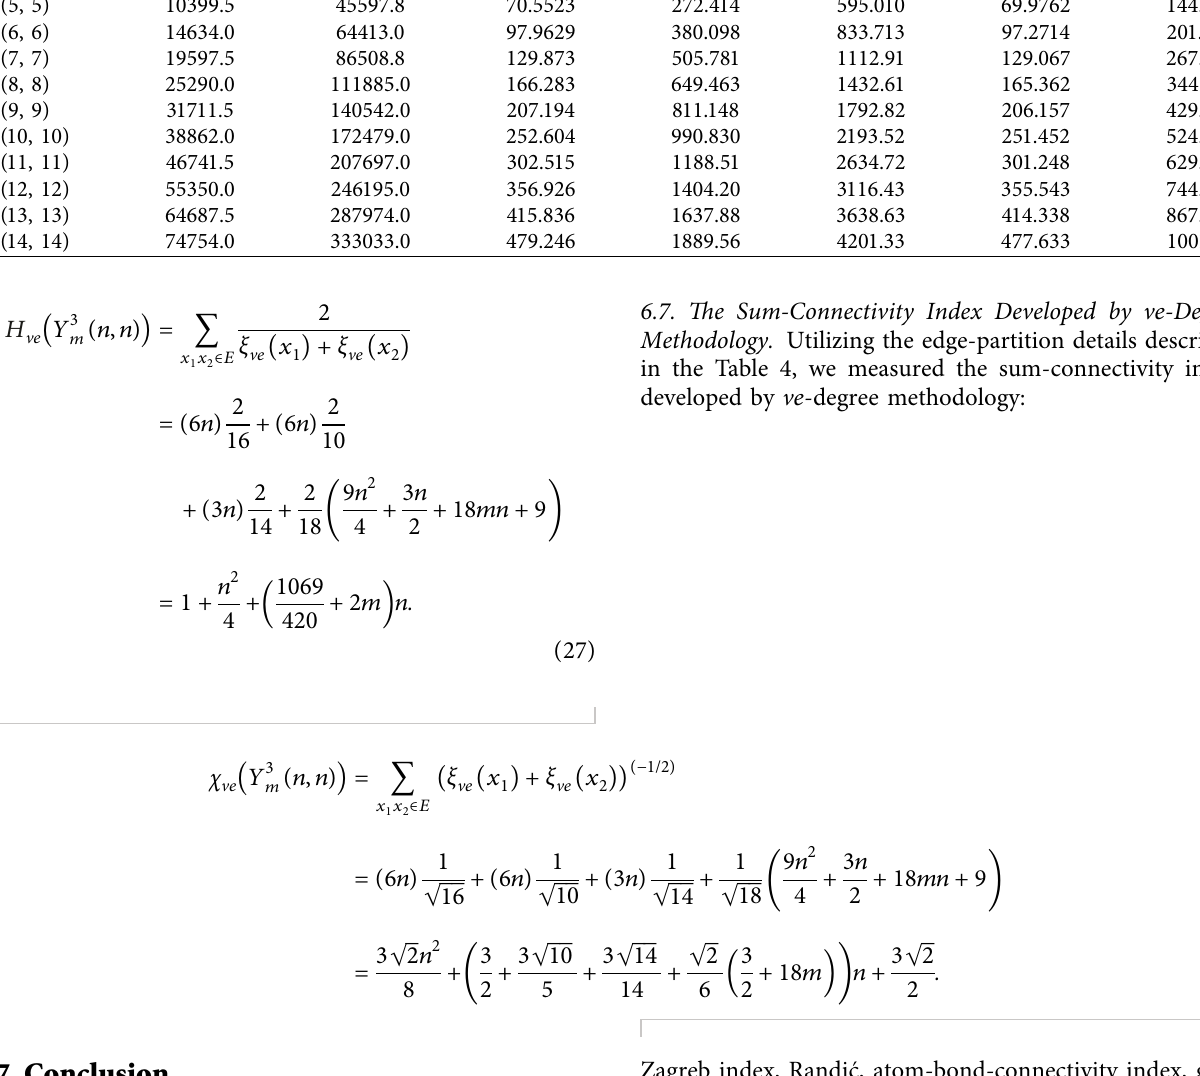
Table 7: Numerical comparison of M 1